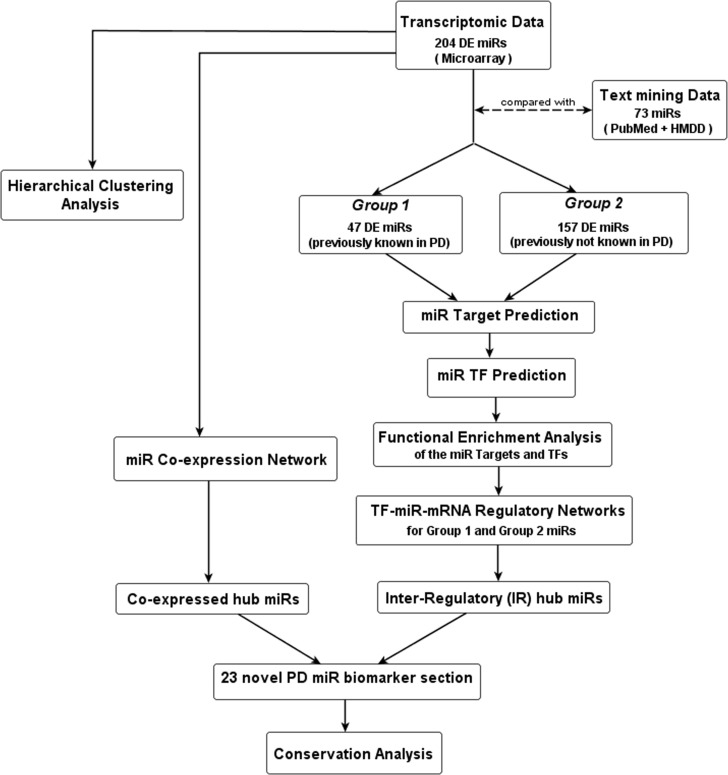
Flowchart depicting the workflow of this study.